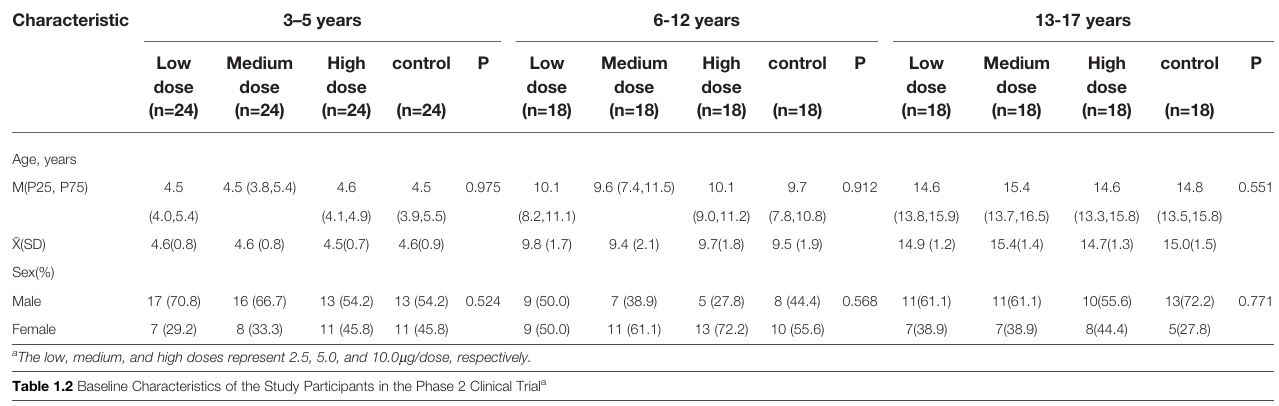
Table 1.2 Baseline Characteristics of the Study Participants in the Phase 2 Clinical Trial a